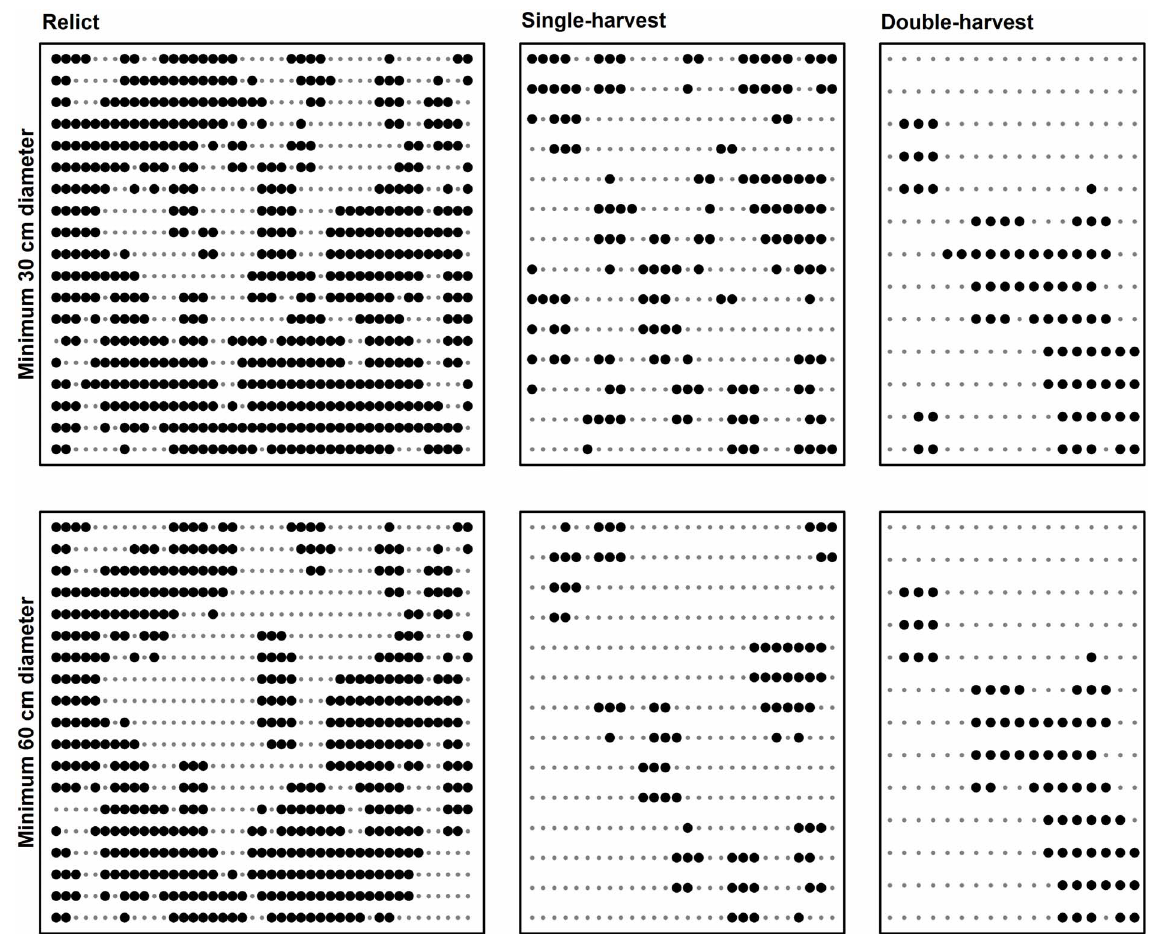
Figure 5. Standing deadwood connectivity examples. Display of connected plots for standing deadwood (SDW) in relict, single-harvest, and double-harvests stands for pieces $ 30 cm (top row) and $ 60 cm (bottom row) based on diameter at 1.37 m height. Large dots indicate plots that sampled at least one SDW piece of the stated size, and small dots indicate plots with no SDW pieces of designated size sampled.